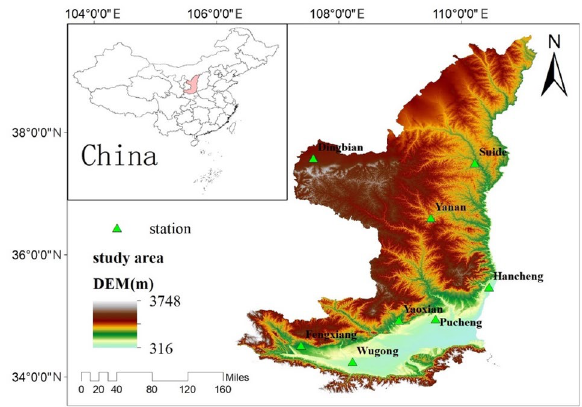
Figure 1. Location of the study area (Arcmap10.8 https:// www. resdc.